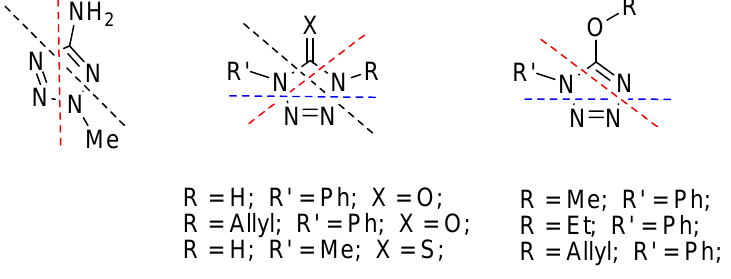
Figure 2. Photodecomposition patterns observed for several tetrazole derivatives in criogenic